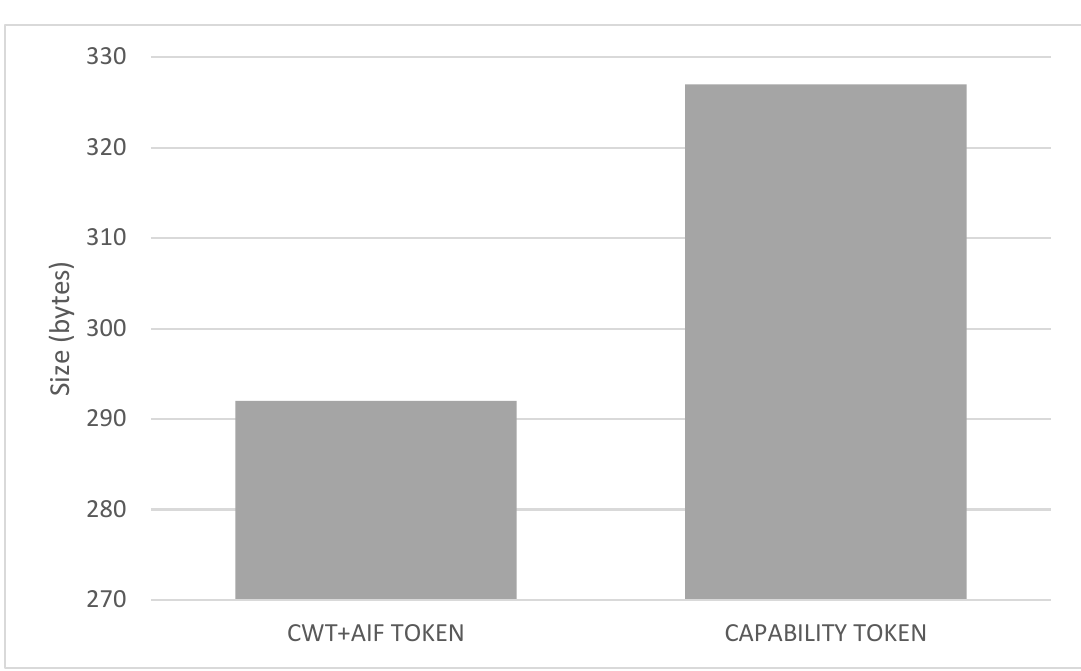
Figure 6. Overload of the MUD management during the bootstrapping.